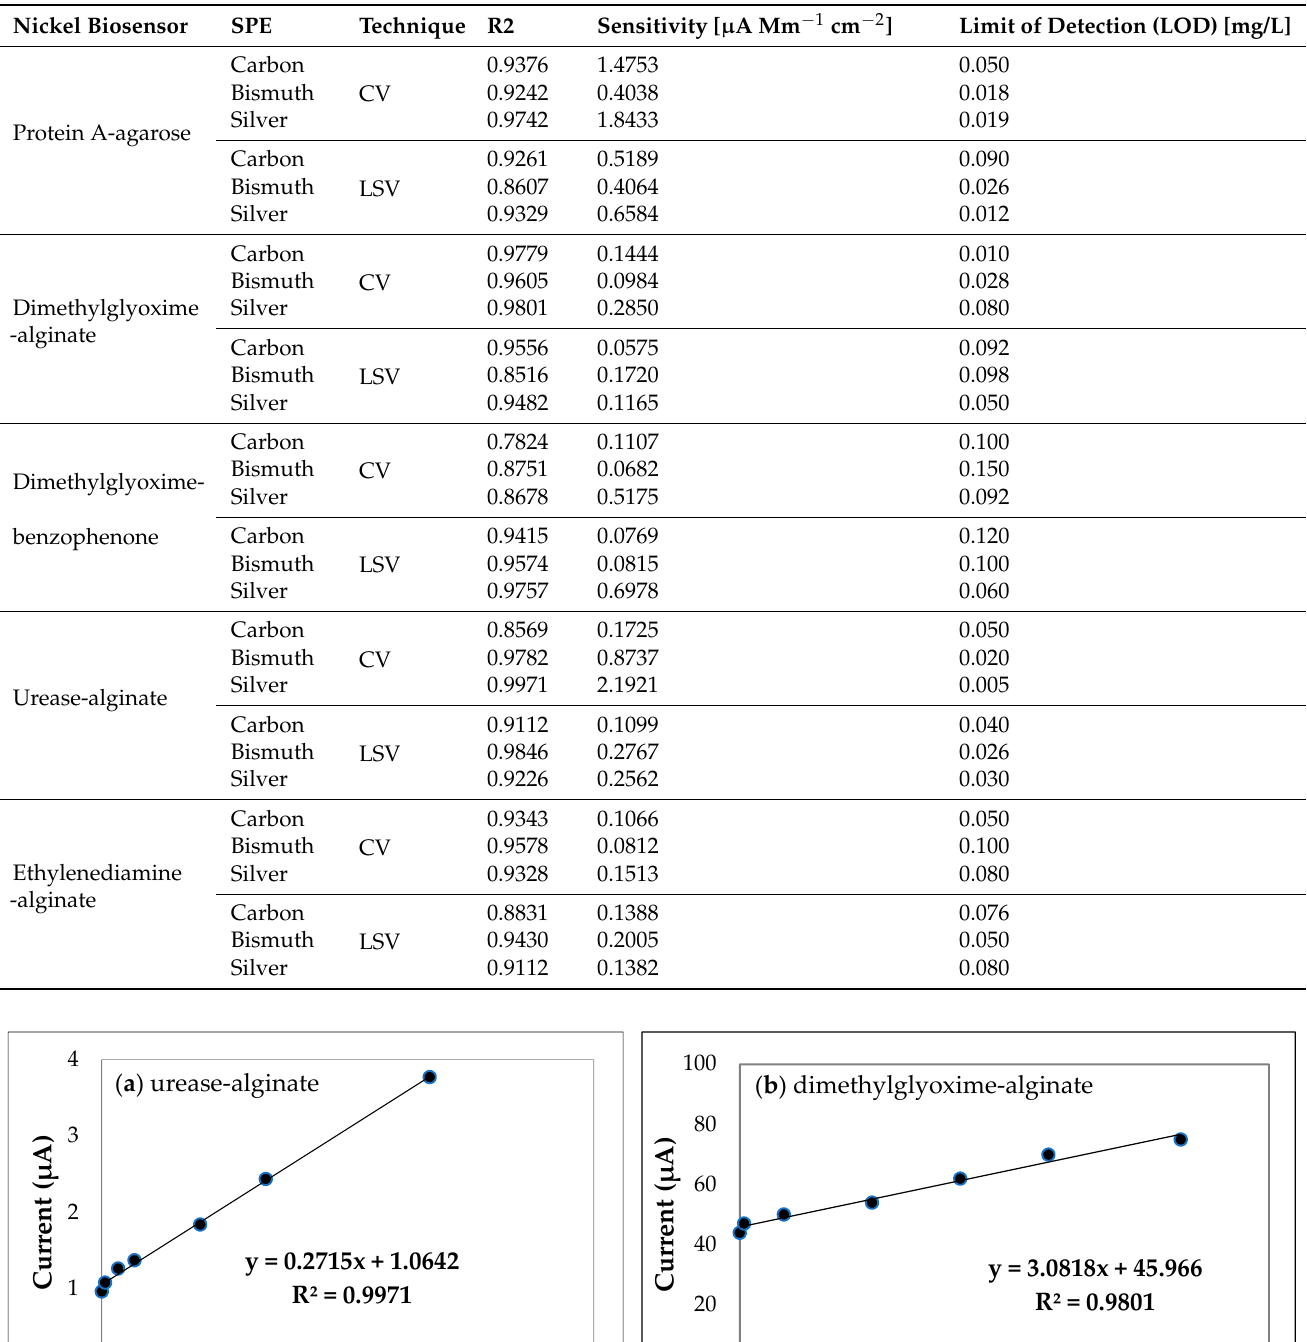
Table 1. Analytical performance characteristics of the five biosensors analyzed. LSV = Linear Sweep Voltammetry, CV = cyclical voltammetry.